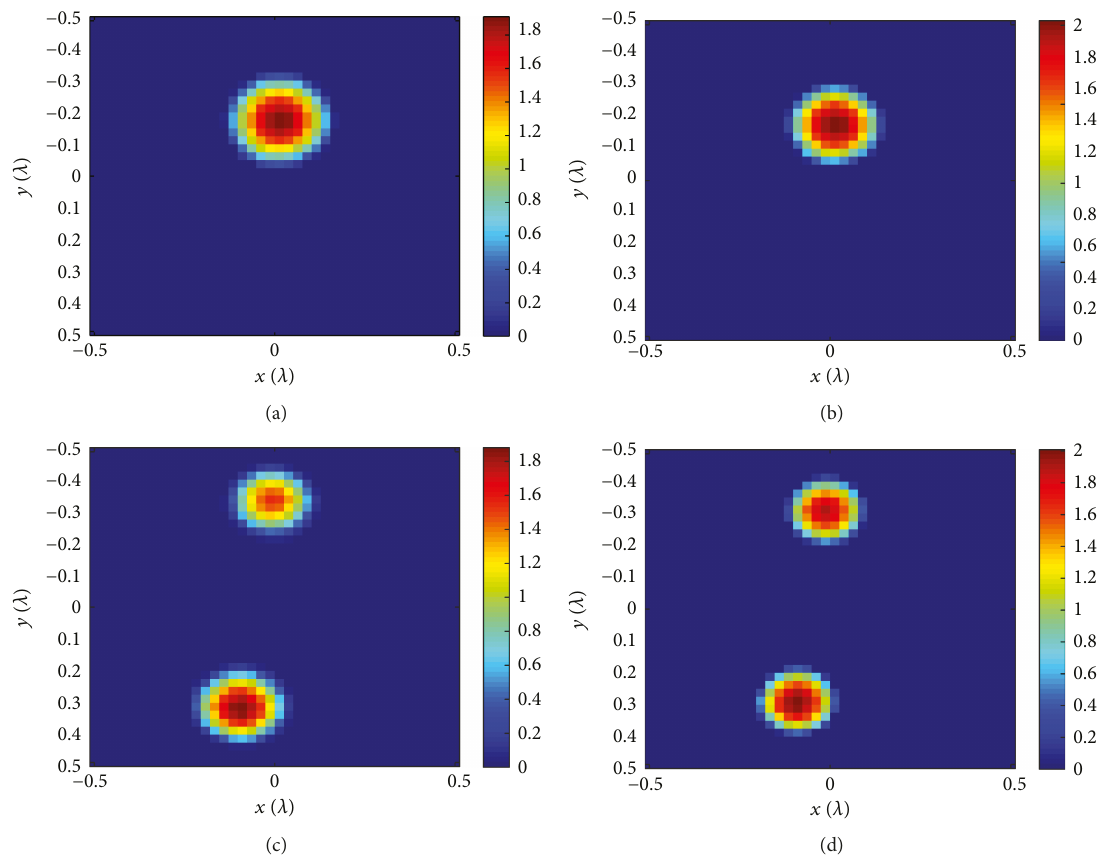
Figure 3: The reconstructed contrast pro fi le in dielTM and twodielTM: (a) dielTM using IN-LW; (b) dielTM using IN-LSQR; (c) twodielTM using IN-LW; (d) twodielTM using IN-LSQR.